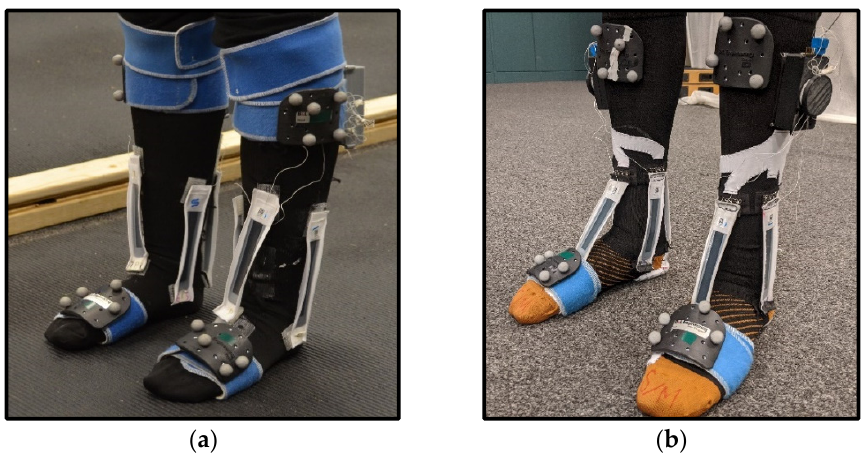
Figure 17. SRS sock mounting system iterations: ( a ) Iteration II and ( b ) Iteration III.